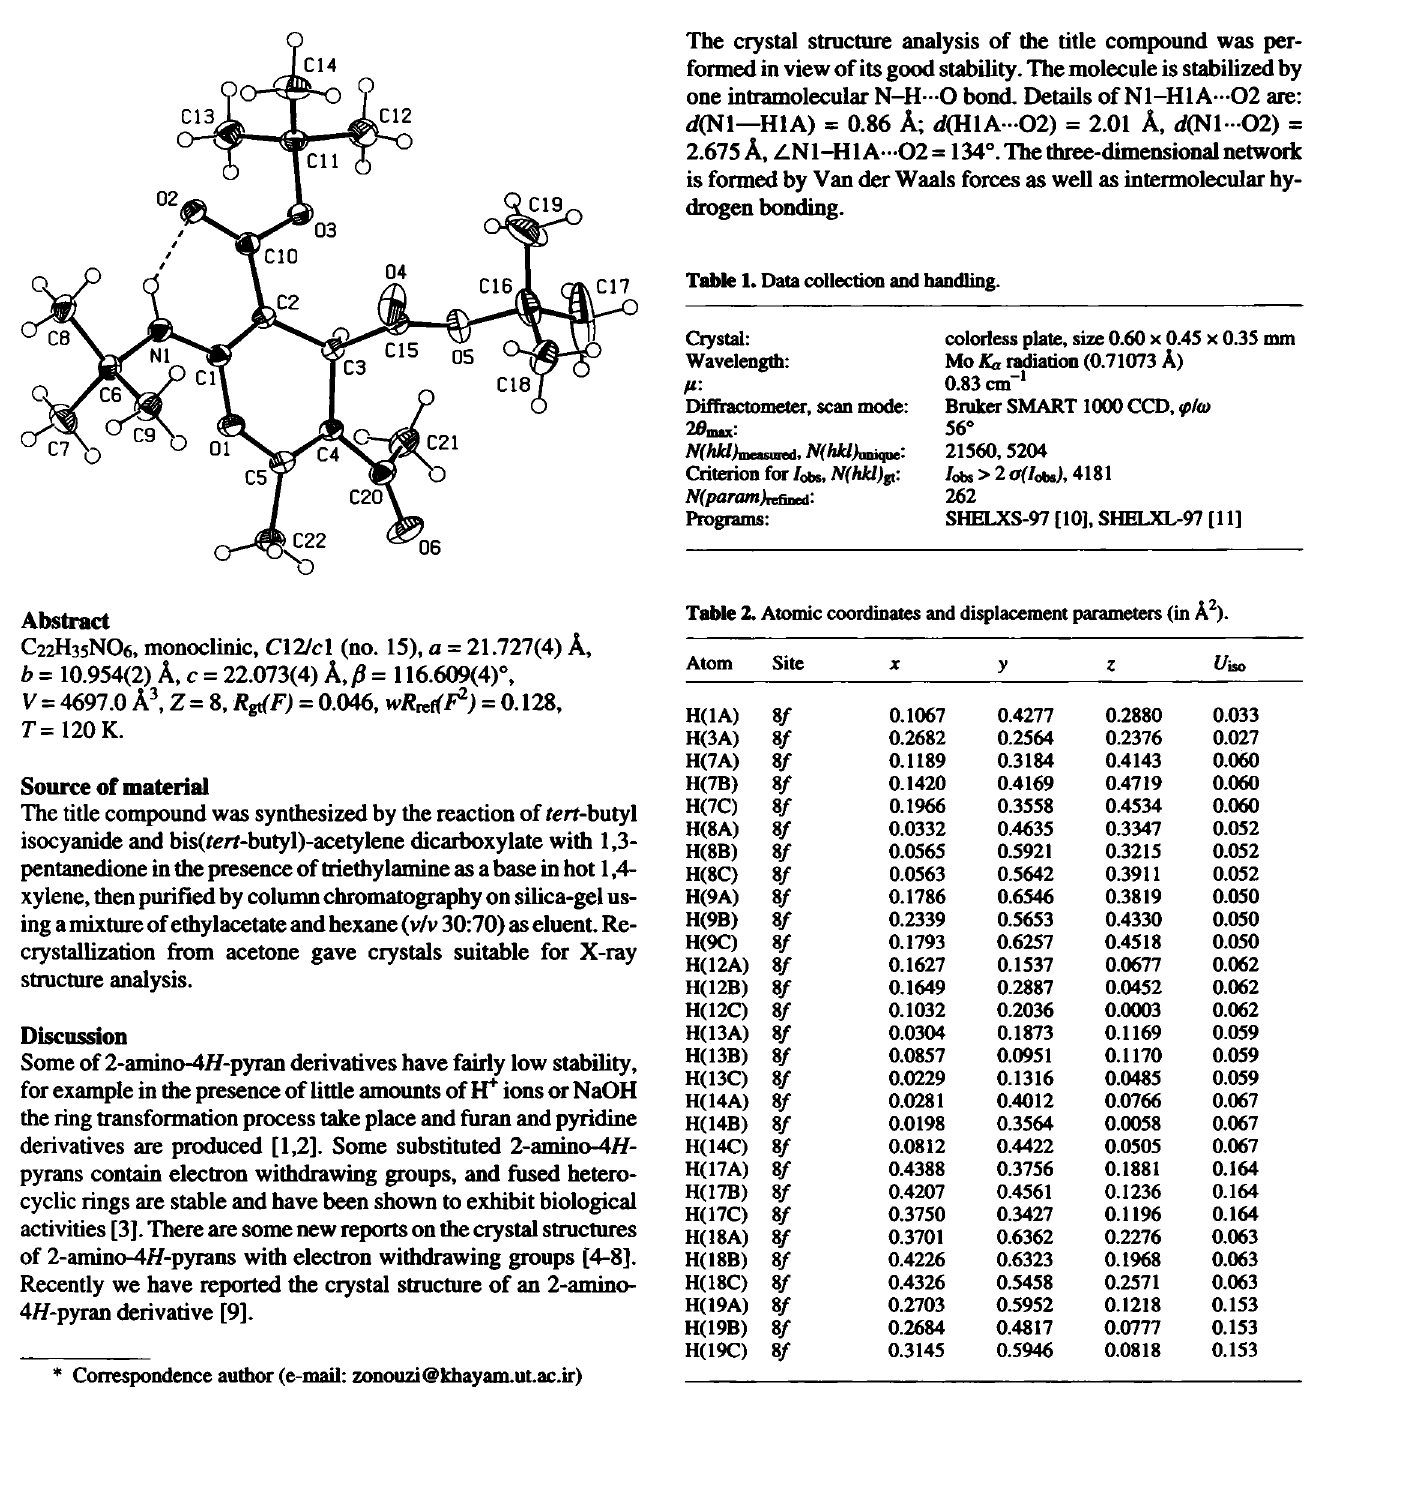
Table 1. Data collection and handling.